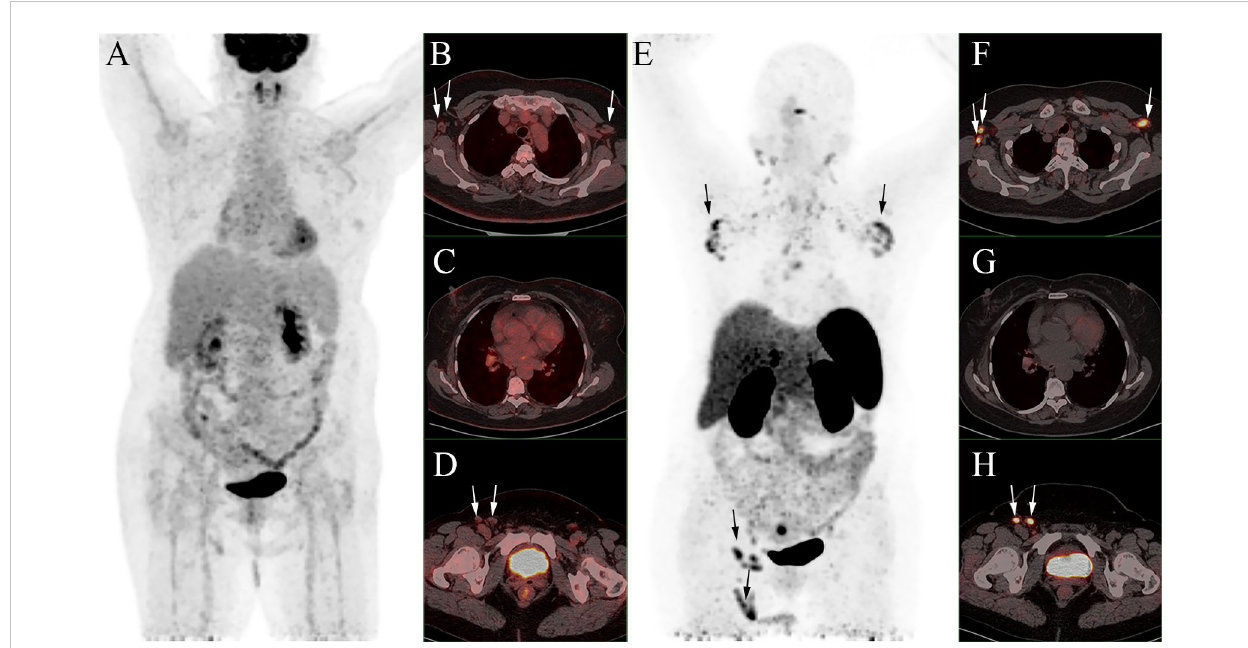
FIGURE 1 No abnormal activity was observed in the 18 F-FDG MIP image (A) . Enlarged lymph nodes were found at bilateral axillary and right inguinal region with mild FDG avidity (SUVmax, 2.1) on 18 F-FDG PET/CT ( B – D fused PET/CT; white arrows) and no abnormality was seen in the bilateral breasts. In the 68 Ga-DOTATATE MIP image (E) and the axial images ( F – H fused PET/CT), higher 68 Ga-DOTATATE uptake than 18 F-FDG was observed in the enlarged bilateral axillary and right inguinal lymph nodes (SUVmax, 8.4; white arrows), and bilateral breasts were still